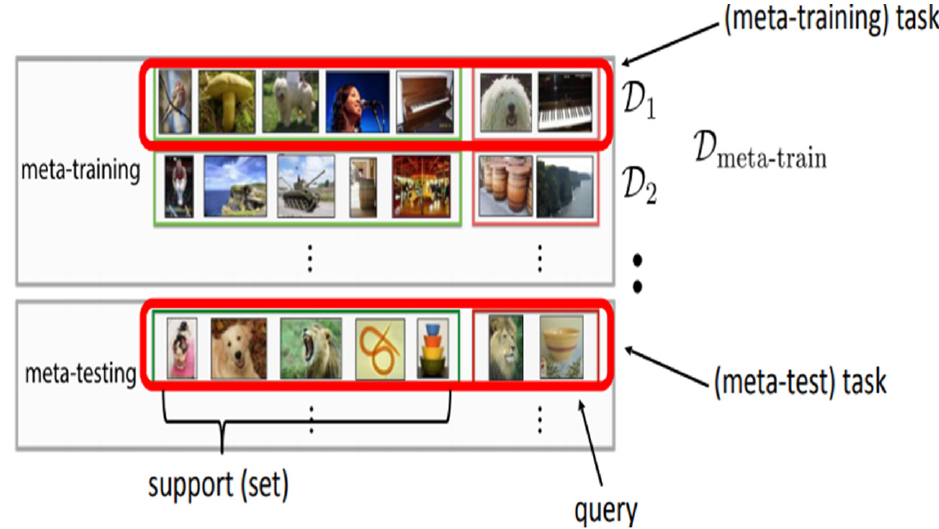
Figure 2. Concept of meta learning.